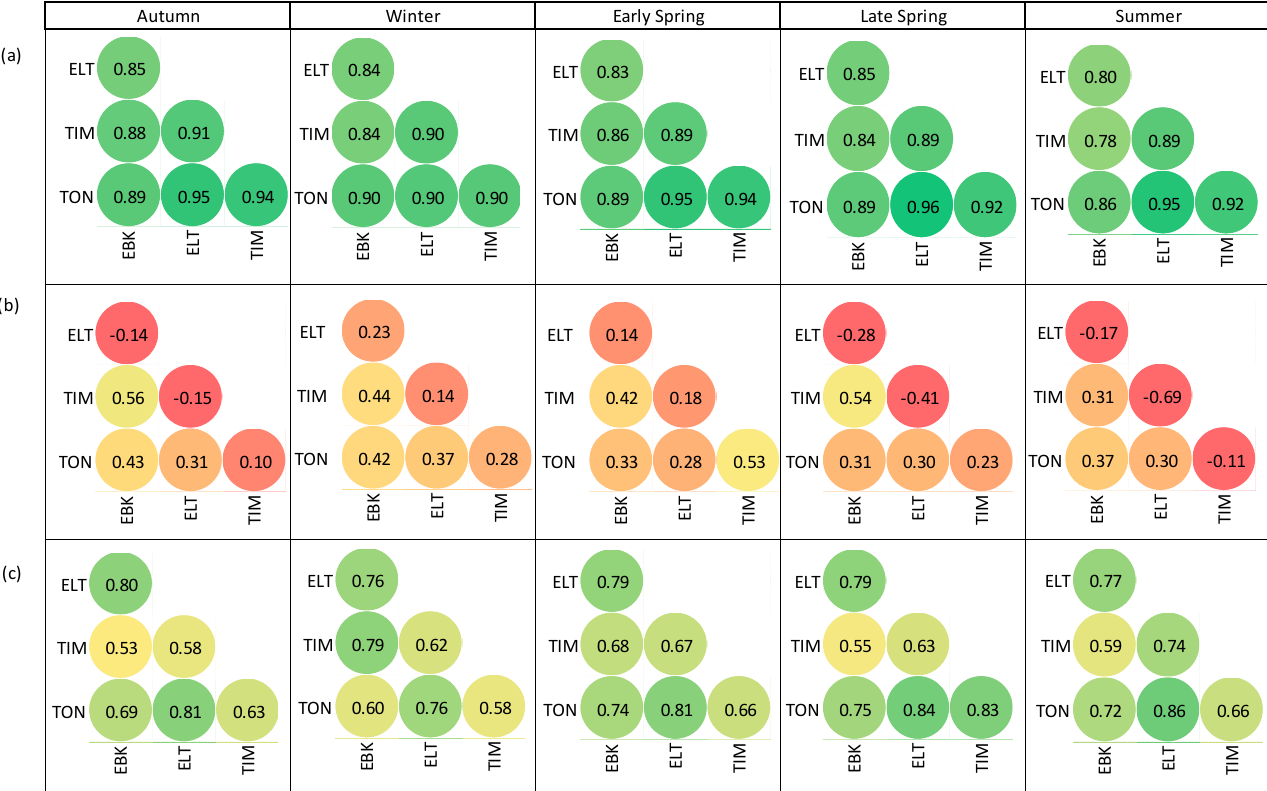
Figure 3. Spearman rank correlations demonstrating how consistently candidates ranked between trial sites (EBK = Ellinbank, ELT = Elliott, TIM = Timboon, TON = Tongala) based on seasonal best linear unbiased predictions (BLUPs) calculated from 3 years of trial data for ( a ) metabolisable energy, ( b ) crude protein and ( c ) neutral detergent fibre.